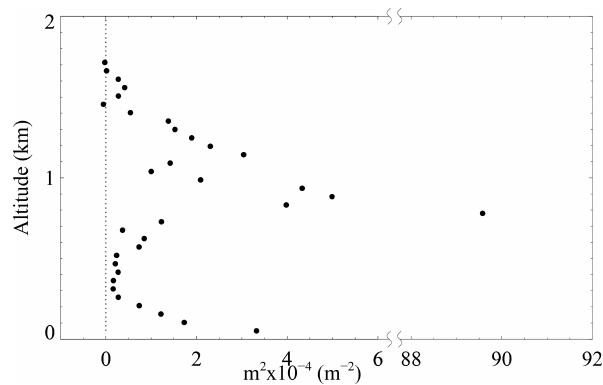
Figure 9. The vertical profile of the vertical wave number squared. The dotted line represents the zero